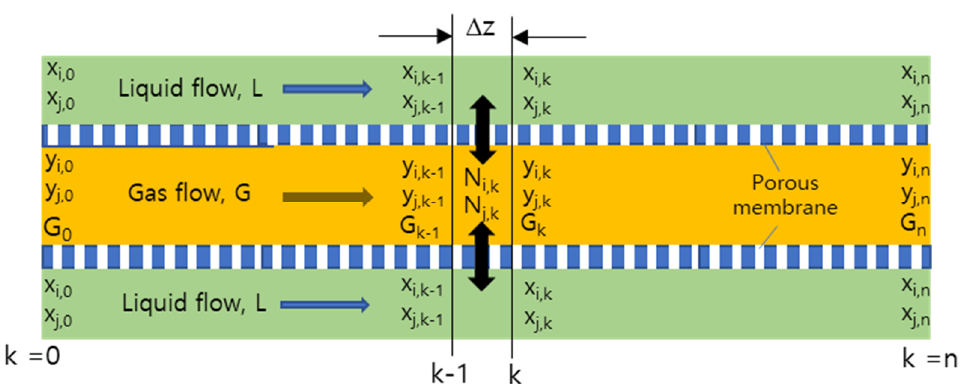
Figure 2. Concentration profile of individual permeant component across porous membrane in membrane contactor: y i and y j = concentrations of components i (preferentially dissolving compo- nent) and j , respectively, G and L = gas and liquid flow rates in feed and permeate, respectively, J i and J j = fluxes of components i and j , respectively, and the superscript * denoting gas phase at inter- face between gas and liquid.